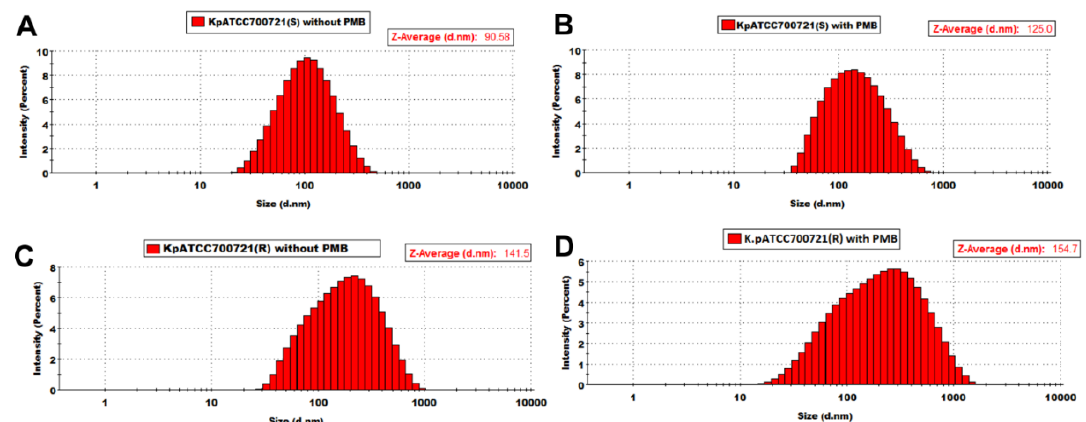
Figure 5. Size distribution measured by dynamic light scattering of OMVs isolated from paired polymyxin-susceptible and -resistant strains of K. pneumoniae ATCC 700721. OMVs isolated from the polymyxin-susceptible K. pneumoniae ATCC 700721 ( A ) without polymyxin B treatment and ( B ) with polymyxin B (2 mg/L) treatment. OMVs isolated from the polymyxin-resistant K. pneumoniae ATCC 700721 ( C ) without polymyxin B treatment and ( D ) with polymyxin B (2 mg/L) treatment.